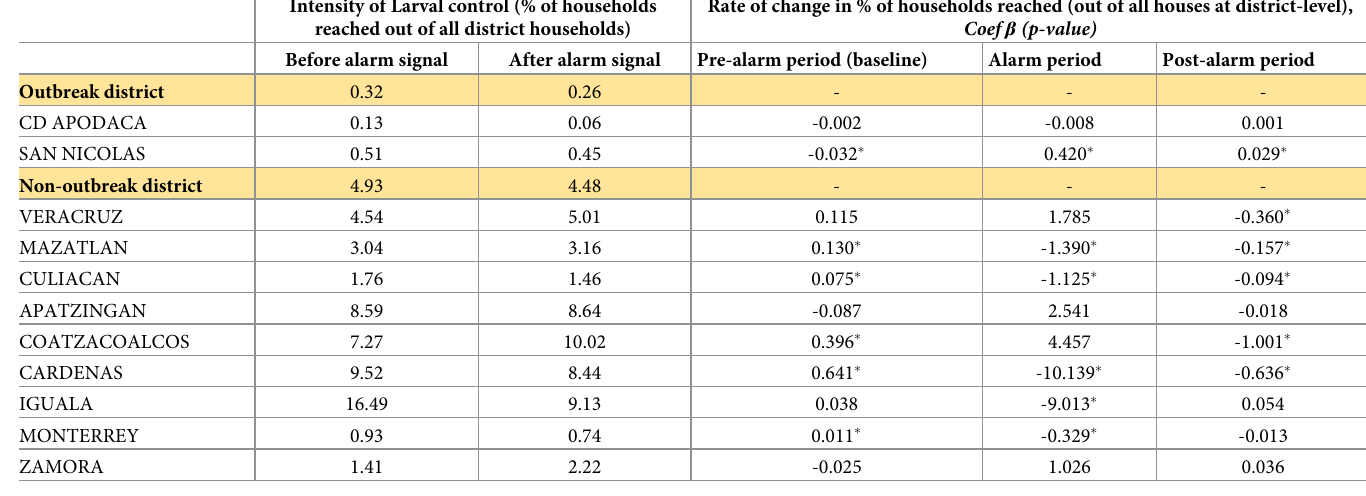
Table 3. Intensity of larval control. Percent of households before and after alarm signals and rate of change between periods in 2 outbreak and 9 non-outbreak districts with alarm signals. Intensity of Larval control (% of households Rate of change in % of households reached (out of all houses at district-level), reached out of all district households) Coef β (p-value) Before alarm signal After alarm signal Pre-alarm period (baseline) Alarm period